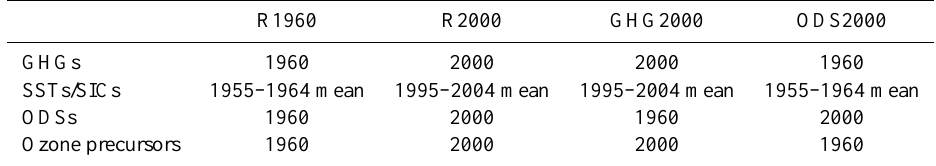
Table 1. Boundary conditions for the four time slice simulations indicated by the year of the input time